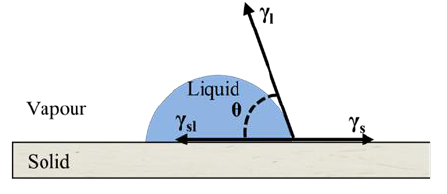
Figure 1. Diagram showing the interfacial tensions and contact angle formed by a liquid drop which describes the interaction